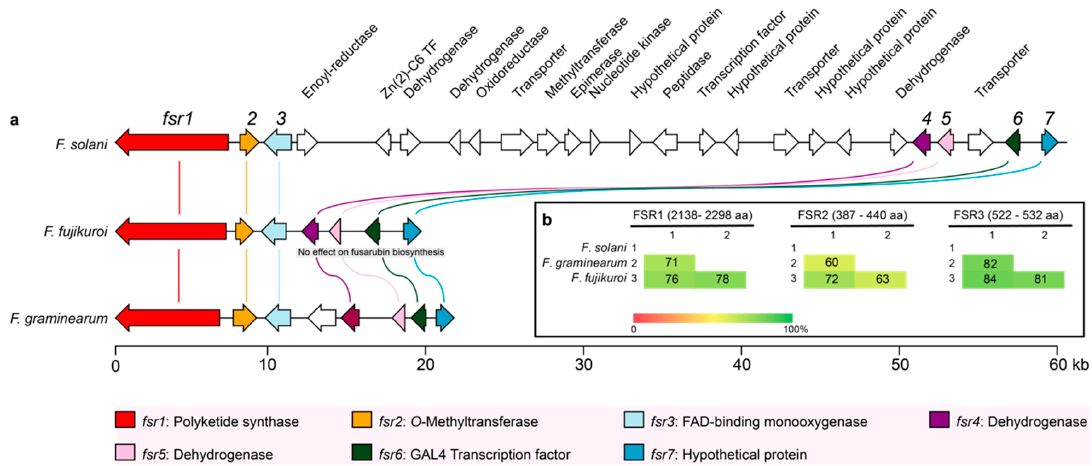
Figure 2. ( a ) Overview of the fusarubin gene clusters in F. solani , F. fujikuroi , and F. graminearum , where the seven conserved genes have been highlighted. The additional genes were tentatively identified using protein prediction software InterPro and NCBI’s Conserved Domain Database (CDD) [22,23]. ( b ) Similarity matrices (% identity) of the amino acid sequences of the three core enzymes based on clustalW alignments.